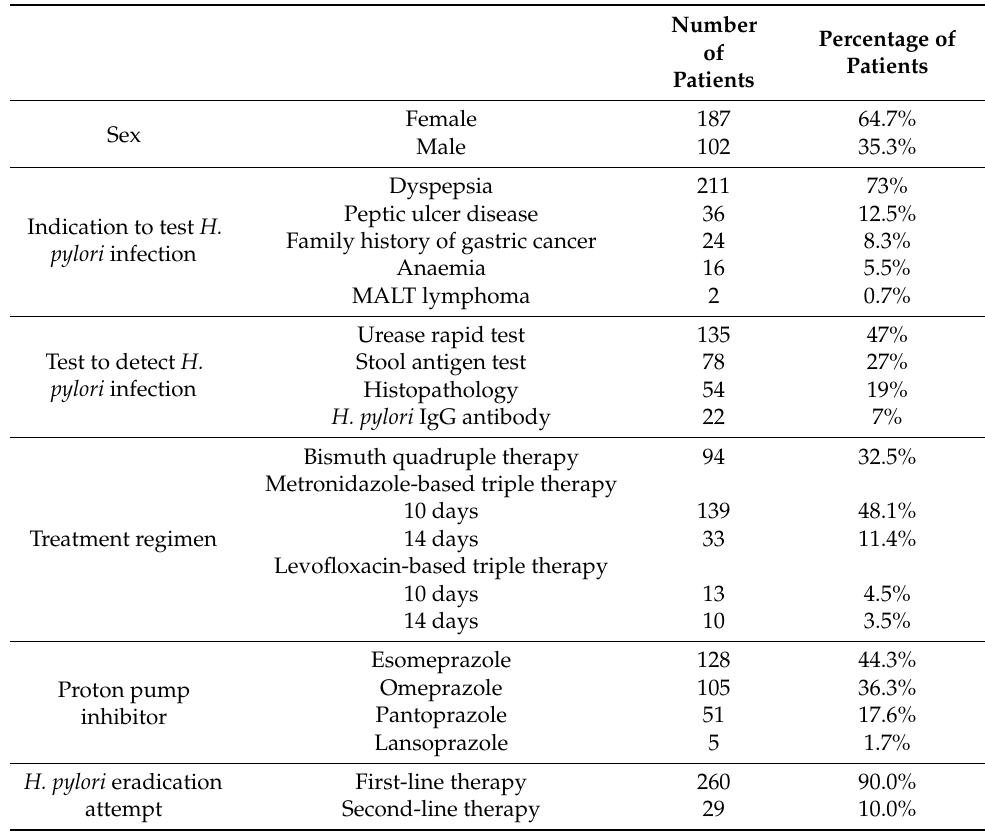
Table 1. Baseline characteristic, diagnostic, and treatment methods of patients included in the analysis.